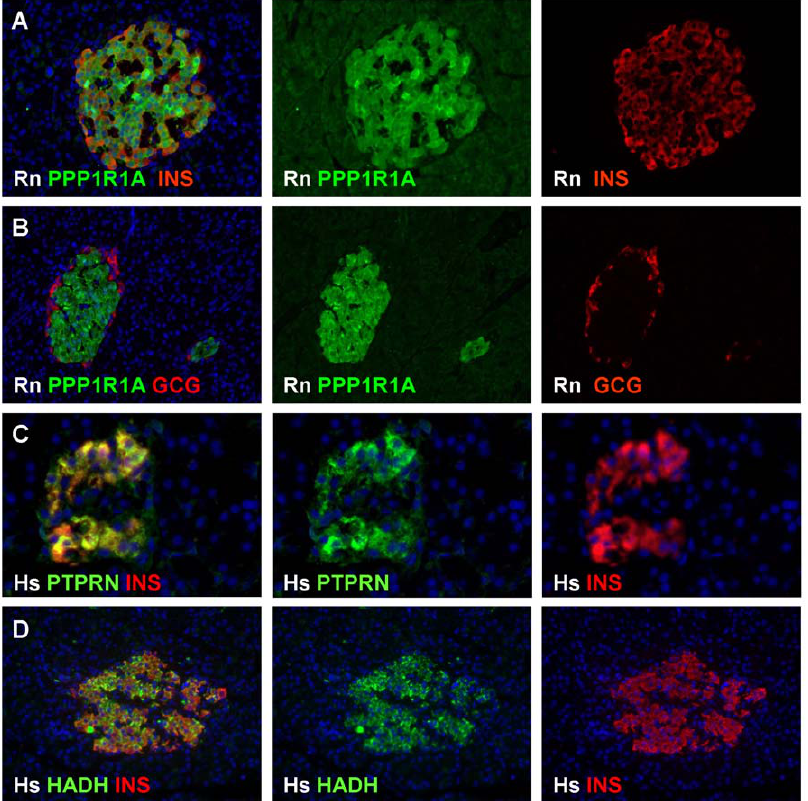
Figure 7. Insitu analysis of beta cell-selective expression of PPP1R1A, PTPRN and HADH proteins. Panels A and B respectively show abundant expression of PPP1R1A protein in insulin + cells and absence in glucagon + cells in islets from 10 w old rats. Beta cell-selective expression of PTPRN and HADH proteins in human beta cells is illustrated in panels C and D respectively. All images are representative of at least 3 different organs with at least 3 sections analyzed per pancreas.